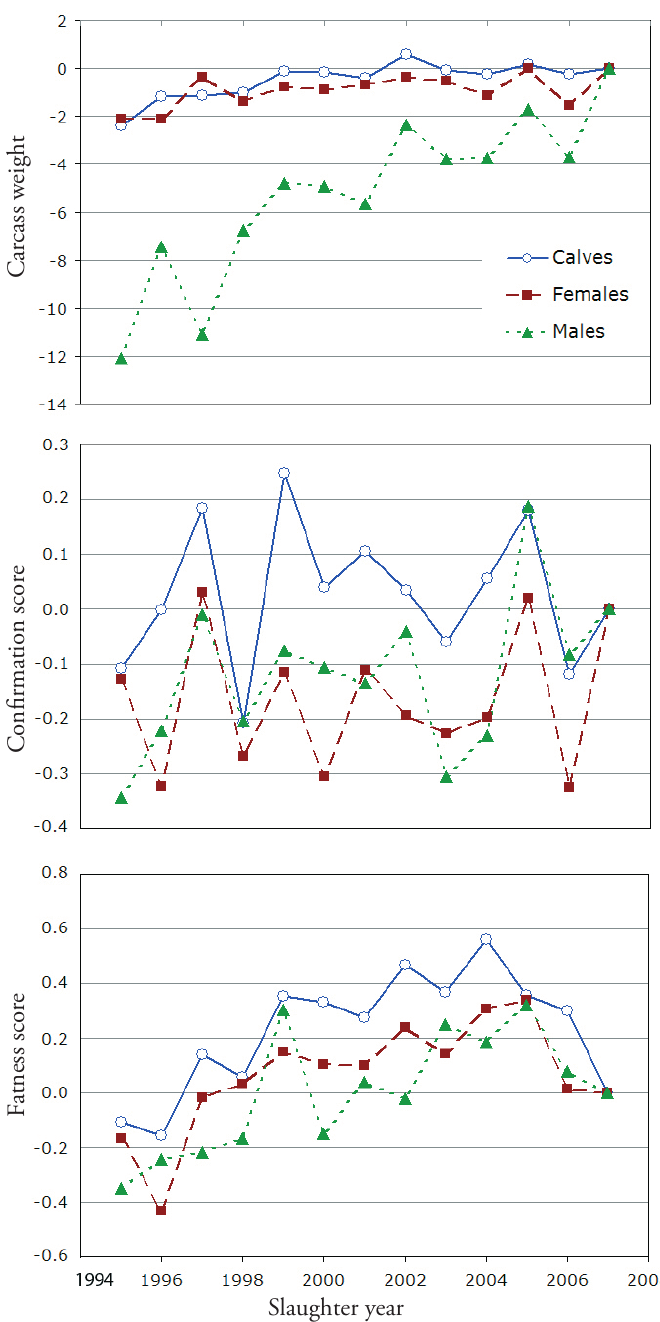
Fig. 1. Estimated effects of slaughter year on carcass weight, con- formation and fatness from the GEE models. The estimates were obtained with the last year, 2007, as the reference year (estimate set to 0). Intercepts for the different carcass measures and animal categories are found in Table